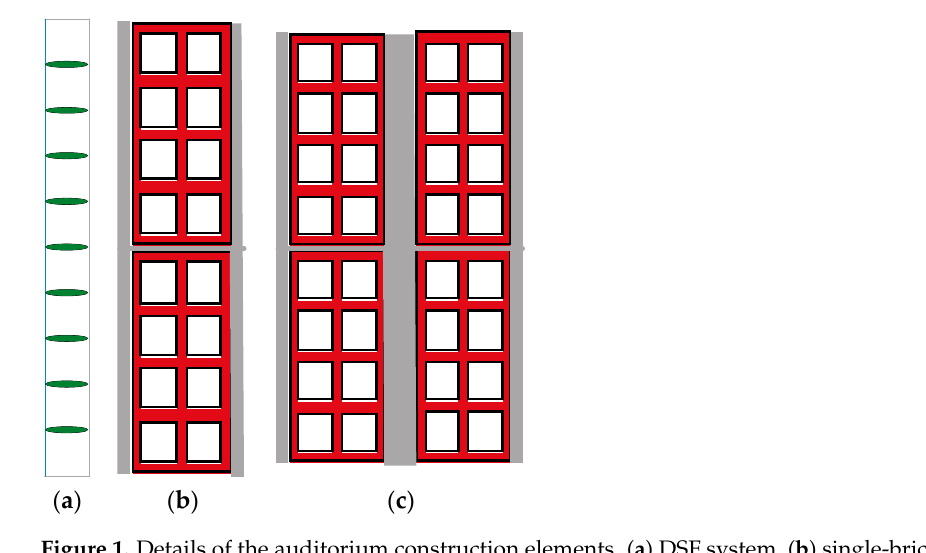
Figure 1. Details of the auditorium construction elements. ( a ) DSF system, ( b ) single-brick scheme, and ( c ) double-brick scheme. and ( c ) double-brick